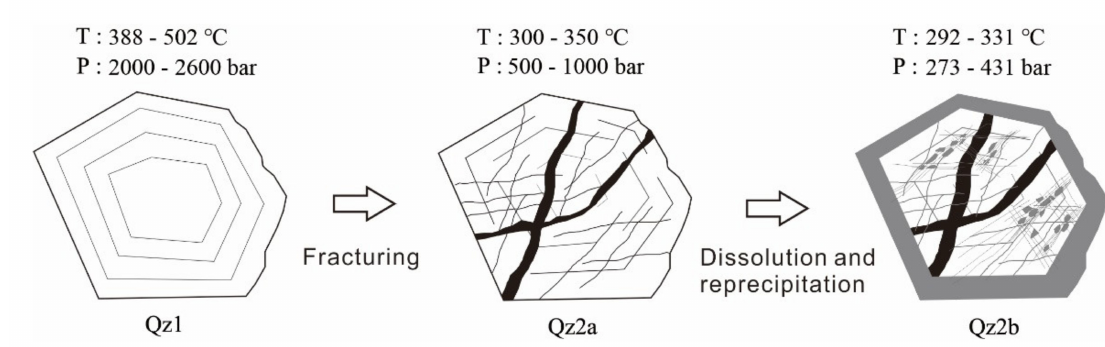
Figure 12. A sketch map of three di ff erent types of quartz in vein generations of Linglong